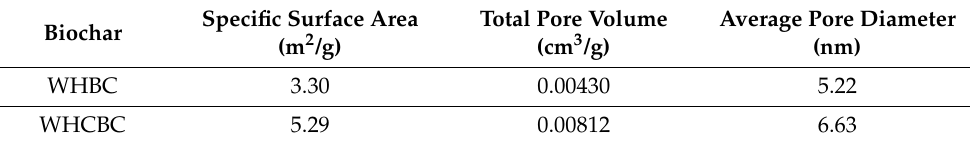
Table 1. Specific surface area and pore parameters of the biochars.